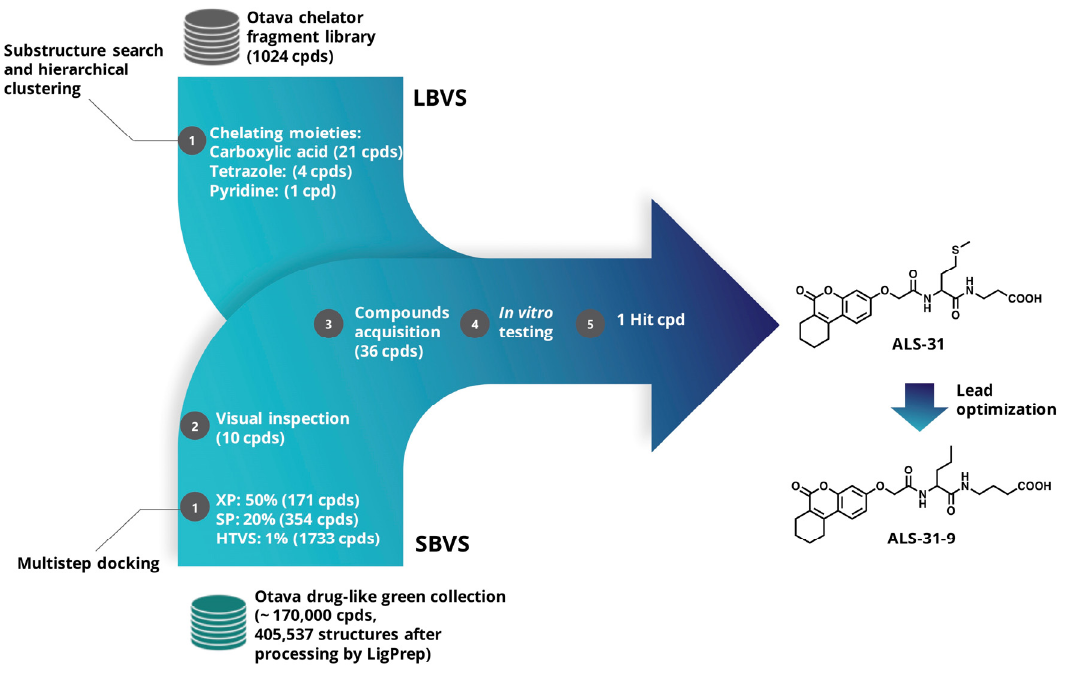
Figure 2. Flow chart of Ligand-based (LBVS) and Structure-based (SBVS) virtual screening ap- proaches.